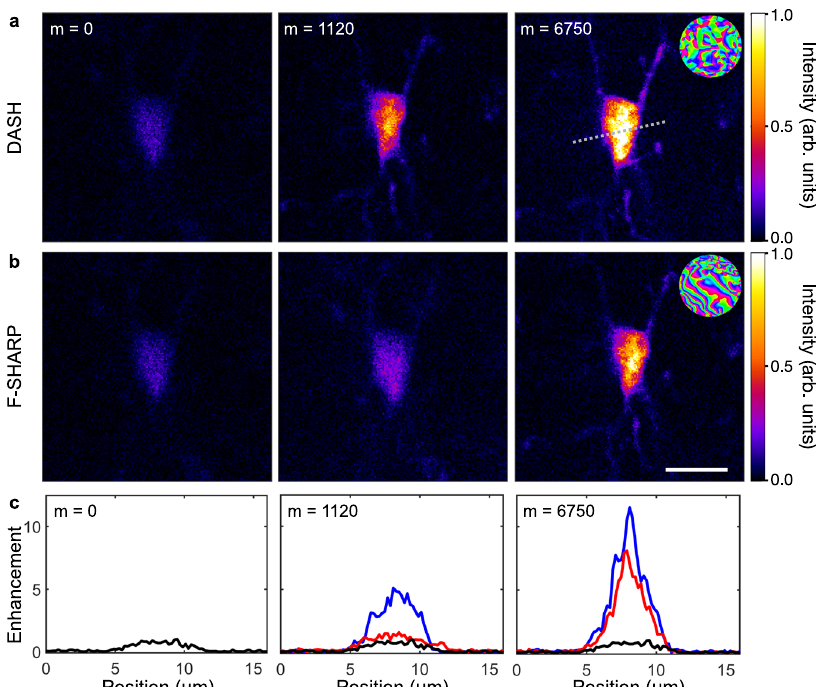
Fig. 3 Scattering correction in mouse hippocampal tissue. a , b Images of a single microglia cell in mouse hippocampal tissue acquired before correction ( m = 0), after the fi rst iteration ( m = 1120), and after convergence of the DASH and F-SHARP algorithms ( m = 10,120), respectively, with the resulting correction masks shown in the inset and scale bar corresponding to 10 μ m. Similar results were reproduced fi ve times. c Pro fi les along the gray, dashed line in part a for no correction (black), DASH correction (blue), and F-SHARP correction